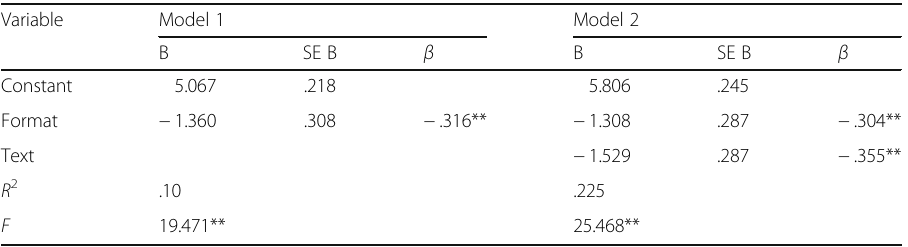
Table 6 Summary of dummy variable regression analysis for variables predicting reading test scores ( N = 90) Variable Model 1 Model 2